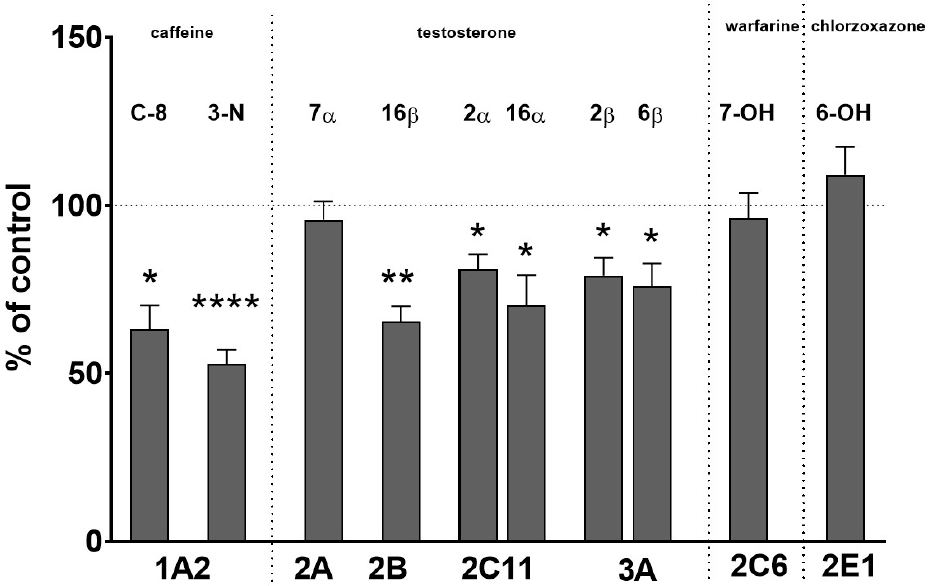
Figure 1. The effect of the chronic treatment of asenapine on activities of different cytochrome P450 enzymes, measured as the rates of CYP-specific reactions in rat liver microsomes: caffeine 8-hydroxylation and 3-N-demethylation (CYP1A), testosterone 7 α - (CYP2A), 16 β - (CYP2B), 2 α - and 16 α - (CYP2C11), and 2 β - and 6 β - (CYP3A) hydroxylation, warfarin 7-hydroxylation (CYP2C6) and chlorzoxazone 6-hydroksylation (CYP2E1). All values are shown as the mean ± S.E.M. (n = 12). Statistical significance was assessed by Student’s t -test and marked as * p < 0.05; ** p < 0.01; **** p < 0.0001, compared to the control. The control values (picomoles per milligram protein per minute) are as follows: 10.70 ± 2.84 (8-hydroxycaffeine), 1.57 ± 0.61 (3-N-demethylcaffeine); 107.5 ± 23.3, 39.8 ± 9.4, 650.5 ± 123.8, 363.4 ± 25.5, 30.9 ± 7.1, and 843.2 ± 257.2 (7 α -, 16 β -, 2 α -, 16 α -, 2 β -, and 6 β -hydroxytestosterone, respectively), 12.9 ± 3.5 (7-hydroxywarfarin) and 3.35 ± 0.8 (nmol/mg protein/min, 6-hydroxychlorzoxazone).